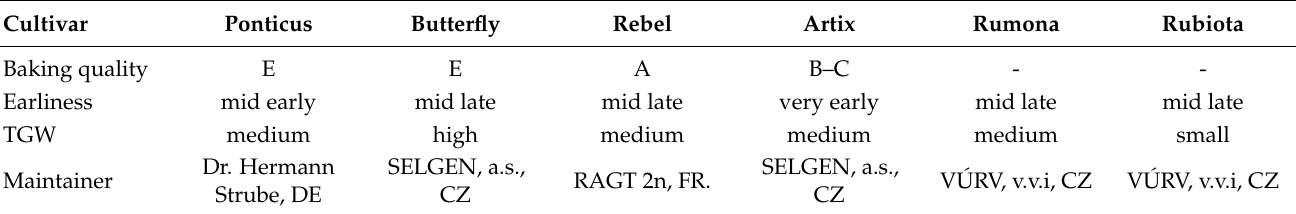
Table 2. Characteristic of